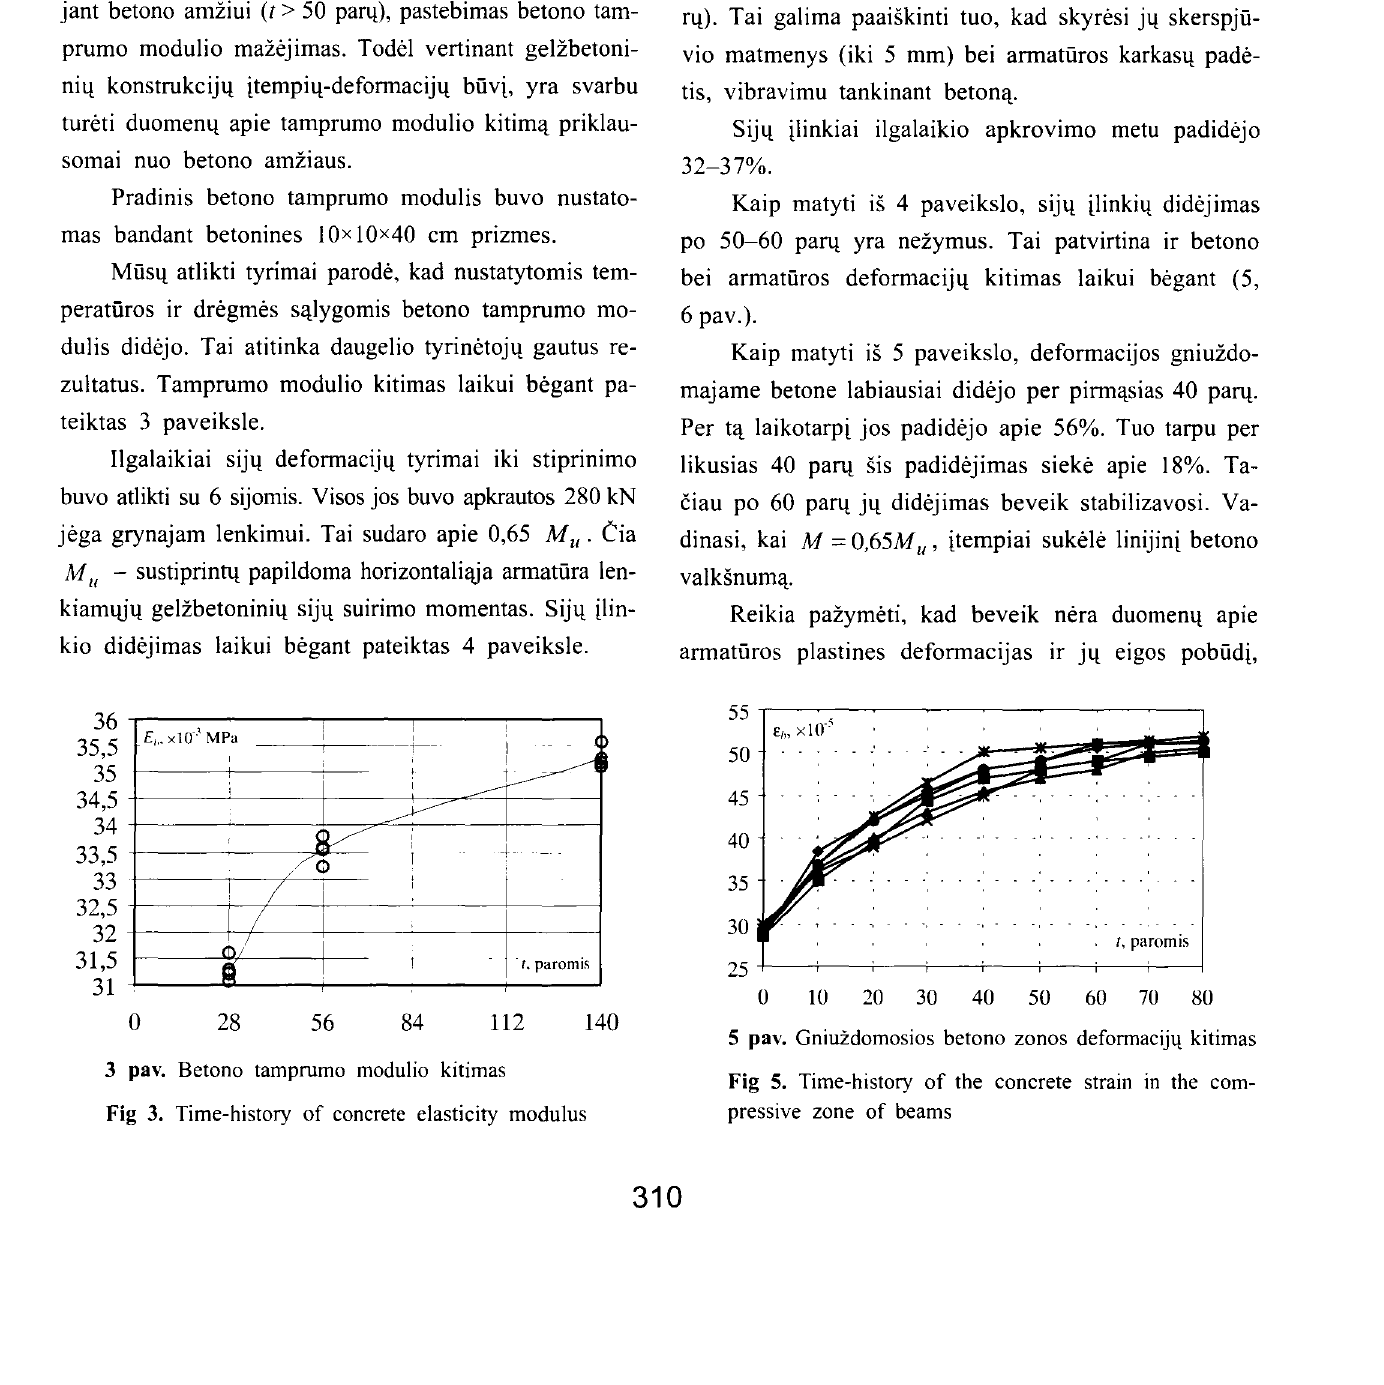
Si4 kreivi4 analize rodo, kad, sijos, nors ir ne:Zy